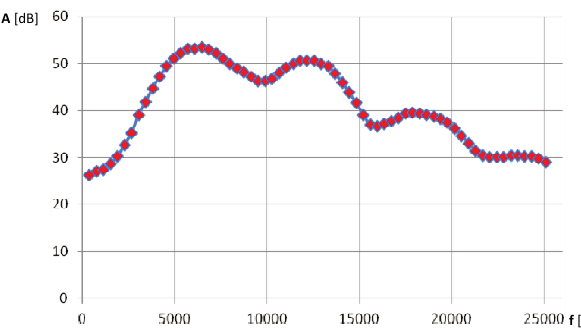
Fig. 7. Mean spectral density values for the set of UU1–UU6 damaged injectors with the exception of UU5